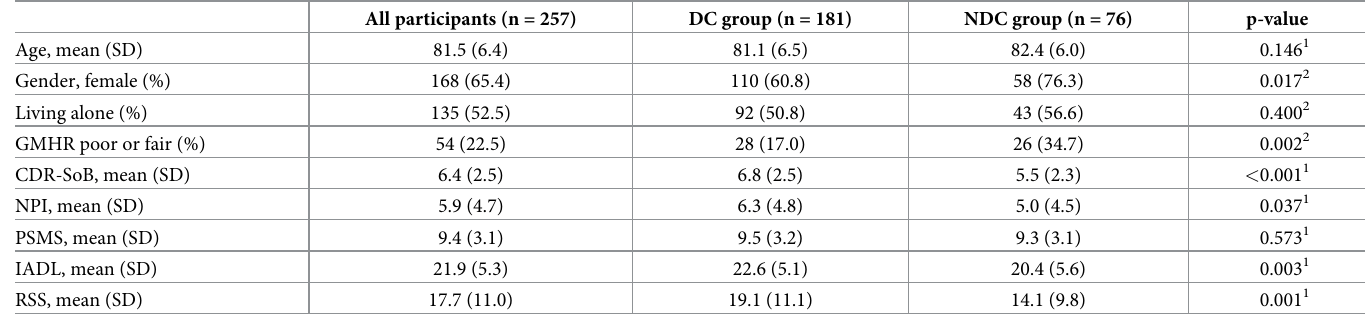
Table 1. Demographic and clinical characteristics at BL for the whole study population and according to whether the participant was in the DC or NDC group.